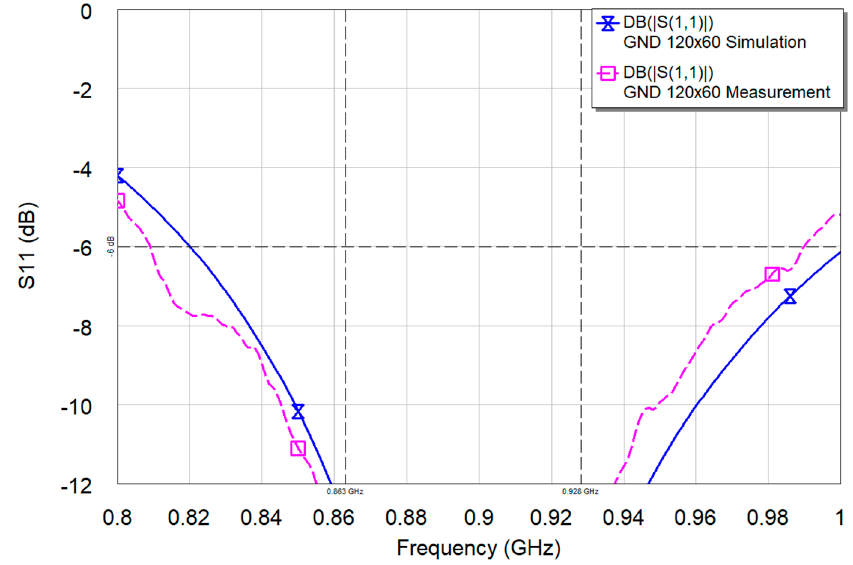
Figure 3. Simulated S 11 for the antenna booster with a matching network (Figure 2) and measurement of S 11 (Figure 4).